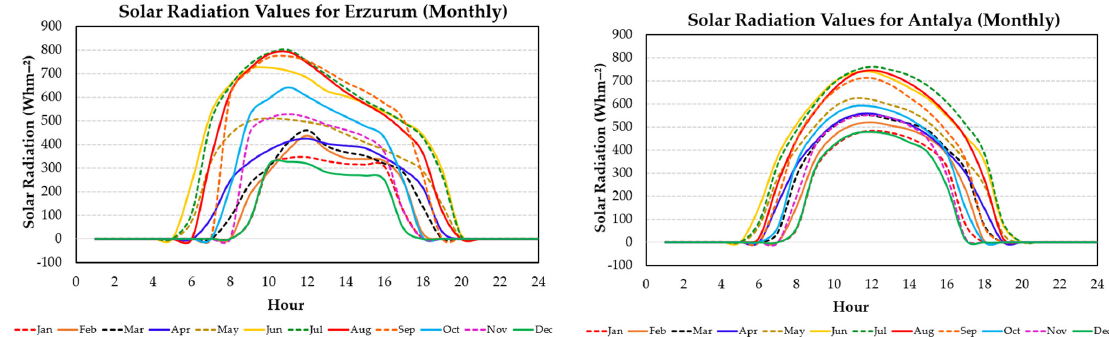
Figure 9. Solar radiation values of